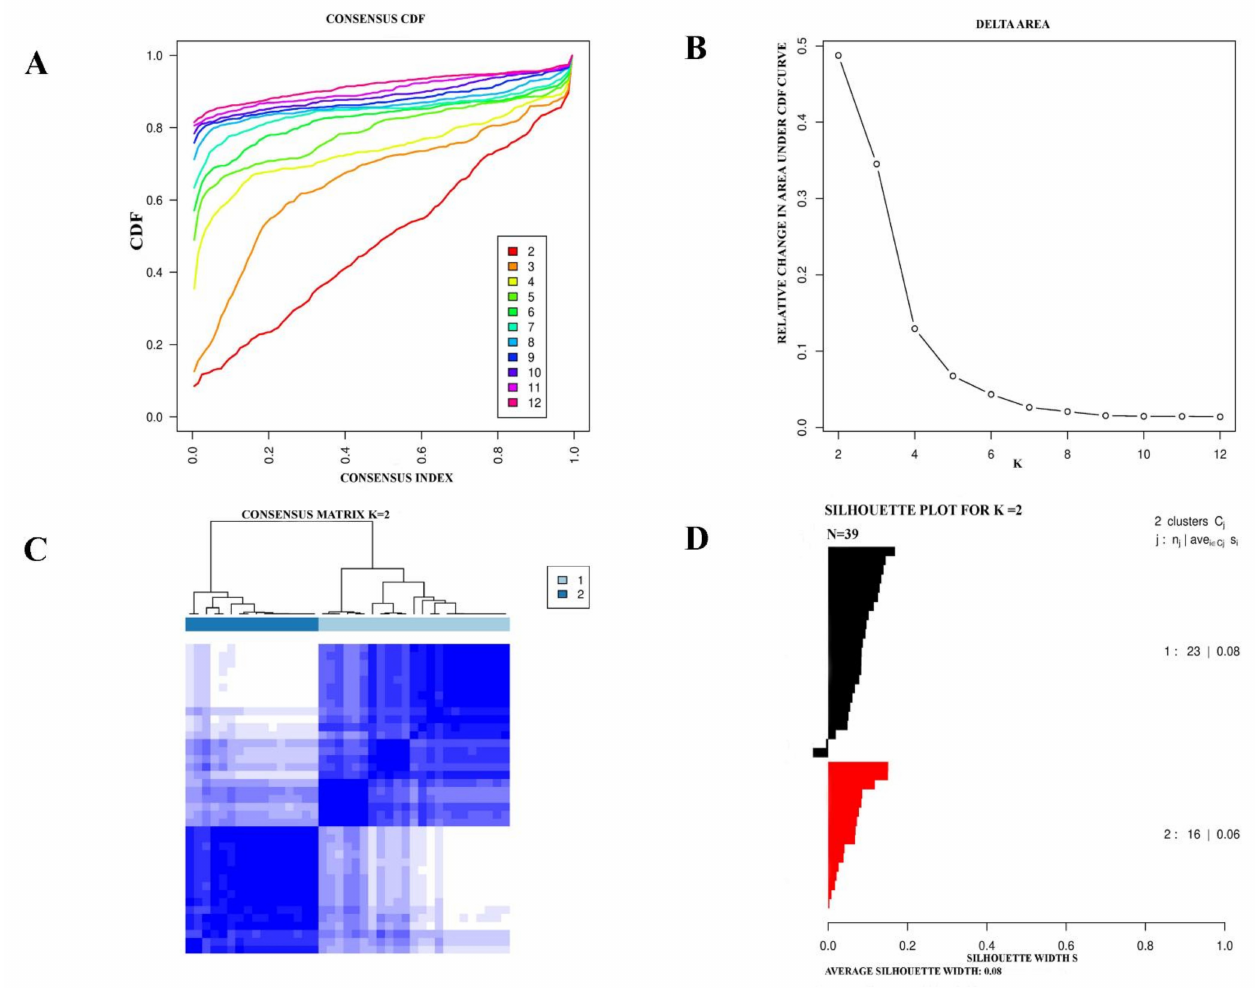
Figure 2. The TCGA cohort of eMPM represented two molecular subtypes. ( A ) An empirical cumulative distribution plot used to determine the optimal number of molecular subtypes for eMPM ( B ). Compared to the prediction of the number of molecular subtypes found using the CDF curve, the area under the CDF curve has increased ( C ). For the two distinct eMPM subtypes, a Consensus clustering matrix has been developed ( D ). Based on the Consensus grouping assignment, a silhouette plot of the eMPM has been